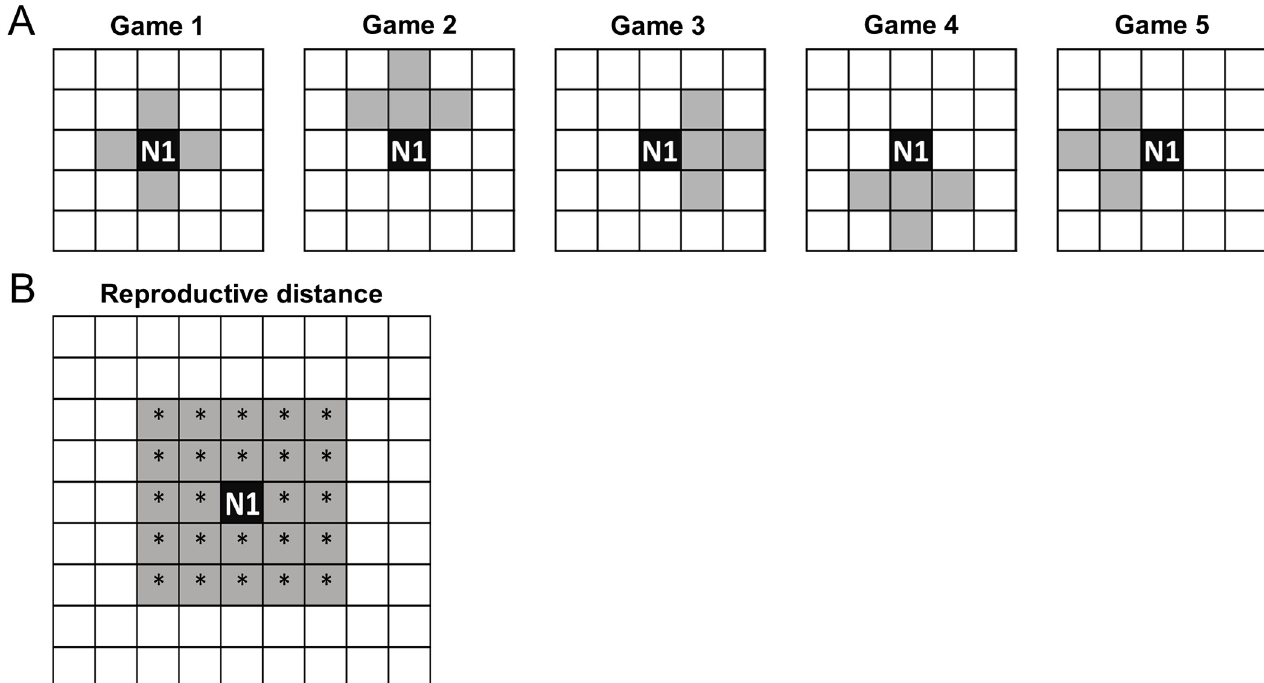
Fig 1. Setup of groups for hunting games and possible offspring agent locations. (A) N1 (black squares) is the location of a single agent. Grey squares represent the neighboring agents that N1 will play the 5 hunting games with during each world update. (B) The locations (grey squares) labeled with � show the possible offspring locations for a parent at location N1 (black square), as we assume offspring remain closer to their parent than do unrelated hyenas. Offspring replace the agent at their location, effectively killing off that agent.